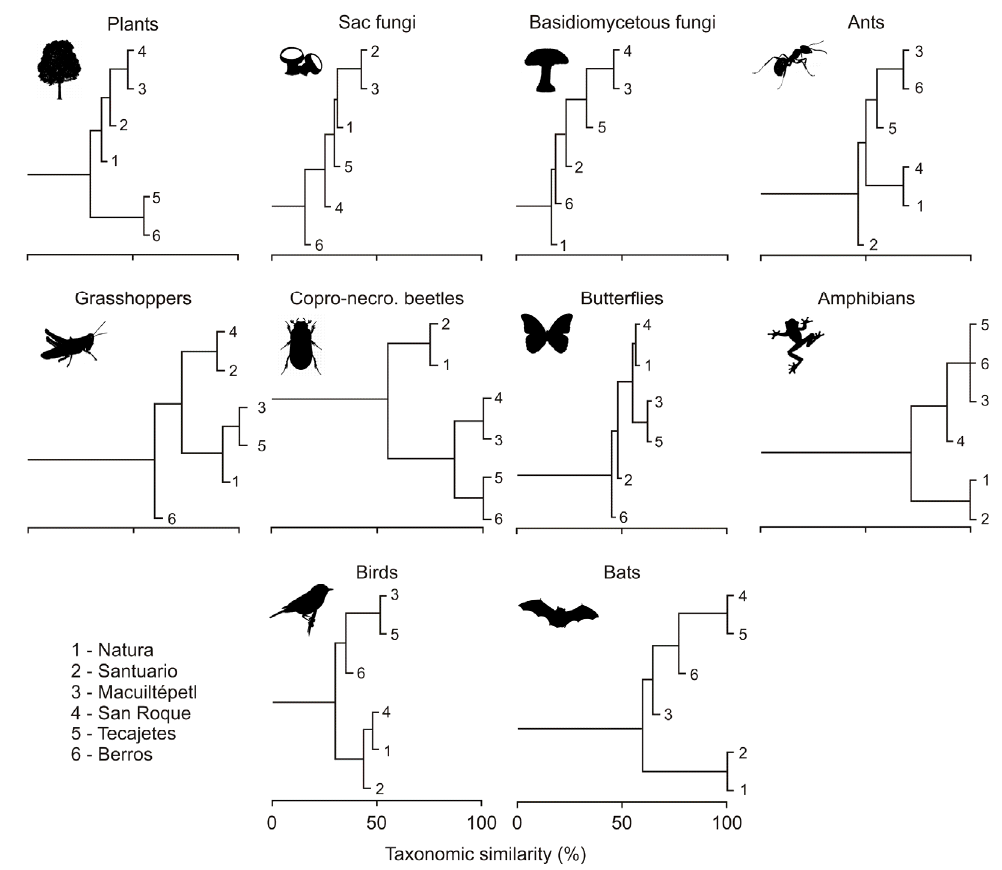
Figure 2. Hierarchical clustering dendrograms showing the taxonomic composition similarity of the studied taxonomic groups among greenspaces.